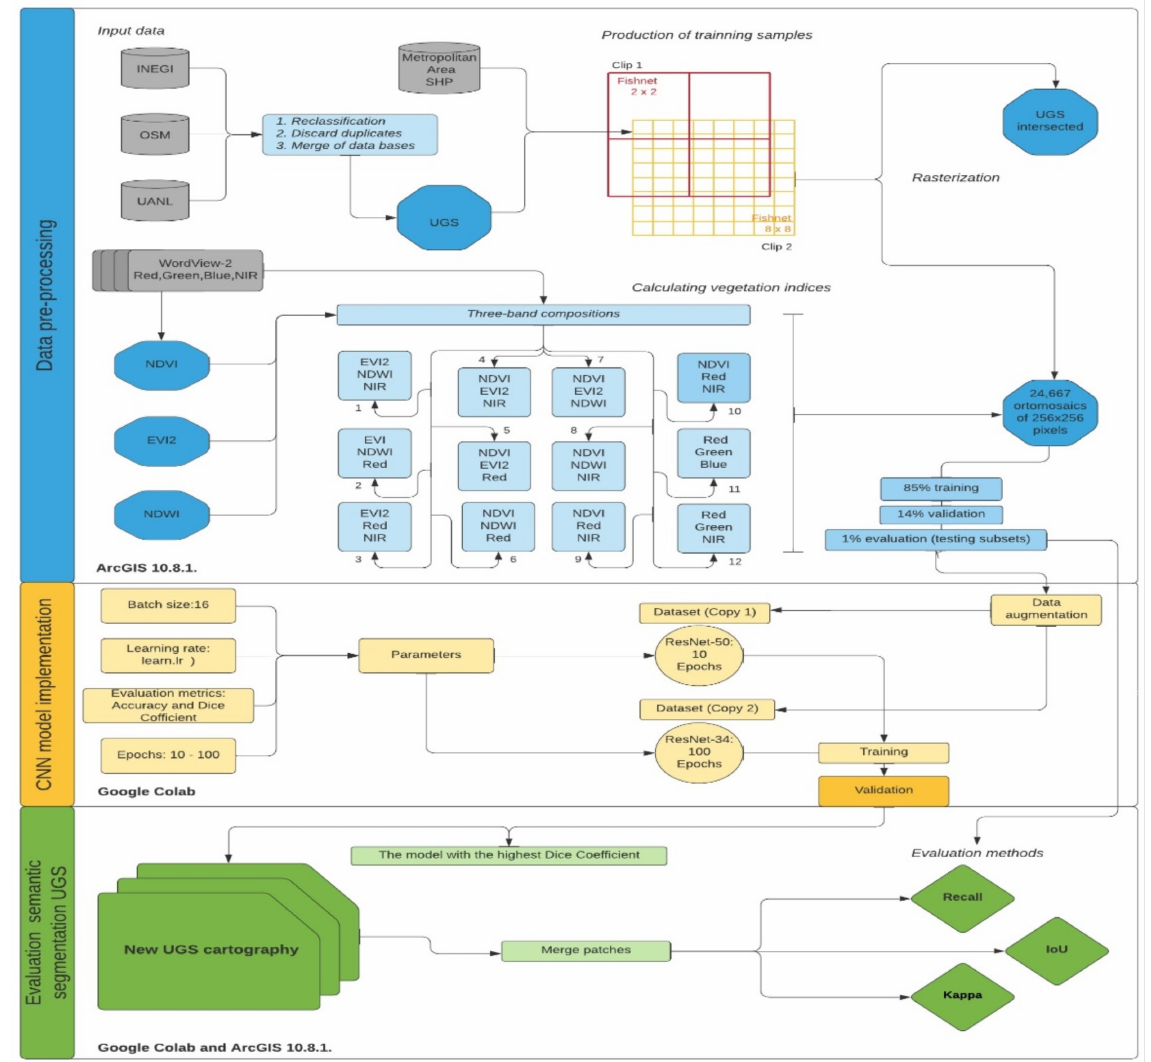
Figure 2. Summary of the current methodological process for semantic segmentation of UGSs using deep learning. Data preprocessing in blue, CNN model implementation in yellow, and evaluation of semantic segmentation of UGSs in green. Input data in gray, and all the processes appear in light blue, yellow, and green. Abbrevation: Urban Green Spaces (UGS), Convolutional Neural Networks